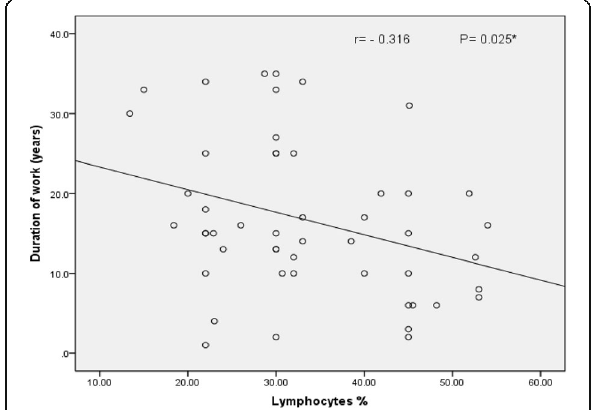
Fig. 4 Correlation between duration of work and lymphocytes